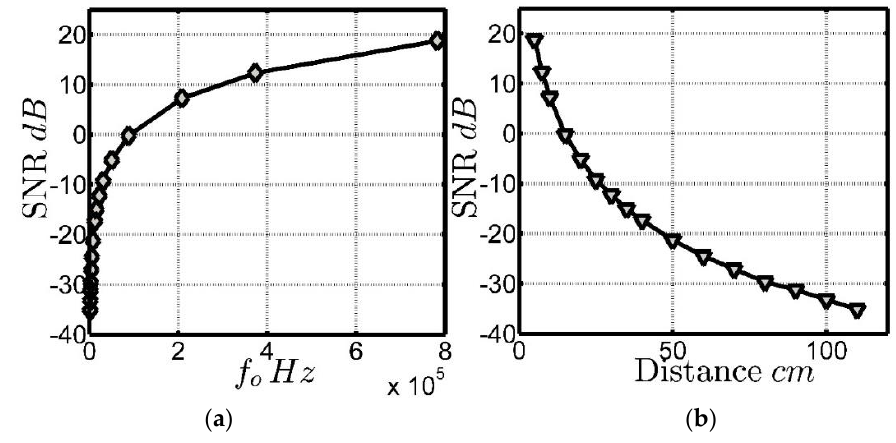
Figure 4. Model description: ( a ) signal-to-noise ratio (SNR) versus LTF output frequency; ( b ) SNR versus link distance.